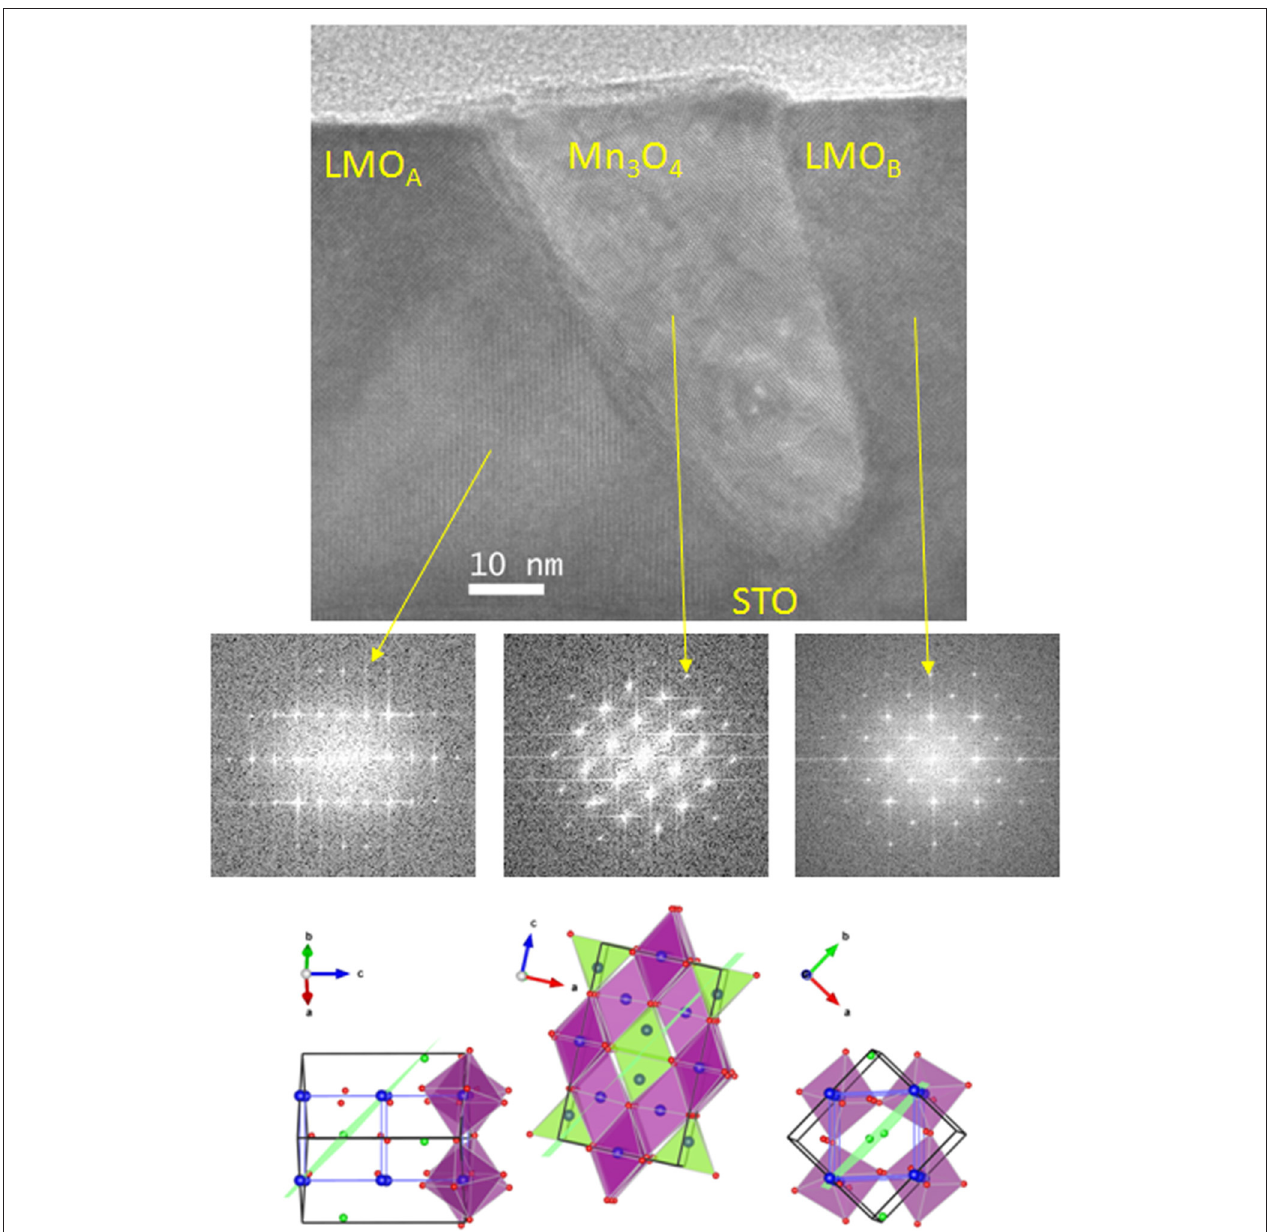
FIGURE 9 | HRTEM images of a Mn 3 O 4 embedded at the interface between LMO domains with [001] or [110] zone axis. Middle panels show the corresponding FFT images obtained from HRTEM images. Schematic representation of the epitaxial relationship is shown in lower panels. Planes used to define epitaxy are painted in green. For clarity, coordination of manganese cations (blue) is shown in octahedral (purple) and tetrahedral (green) positions. Oxygen anions in red and Lanthanum cations in blue are also